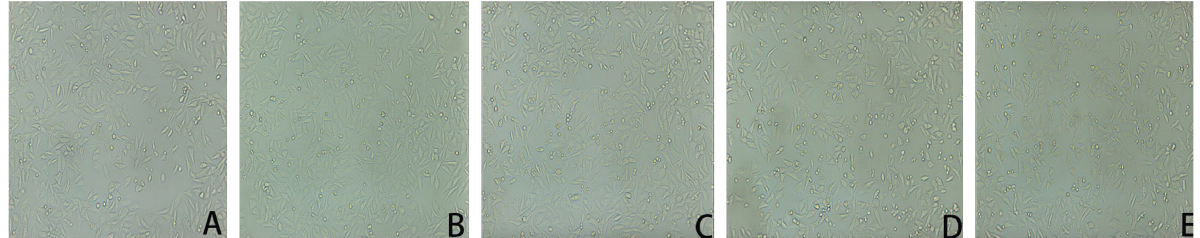
Figure 1: Cell morphology observed under inverted-phase microscopy ( × 100). M¨uller cells were cultured to 80–90% confluence and exposed to hyperbaric or atmospheric pressure for two hours and then to varying concentrations of cyanin chloride (or vehicle) for three days before images were captured. (A) Group A: 0mmHg; (B) Group B: 60mmHg; (C) Group C: 60mmHg + 10 μ mol/L cyanin chloride; (D) Group D: 60mmHg + 30 μ mol/L cyanin chloride; (E) Group E: 60mmHg + 50 μ mol/L cyanin chloride.